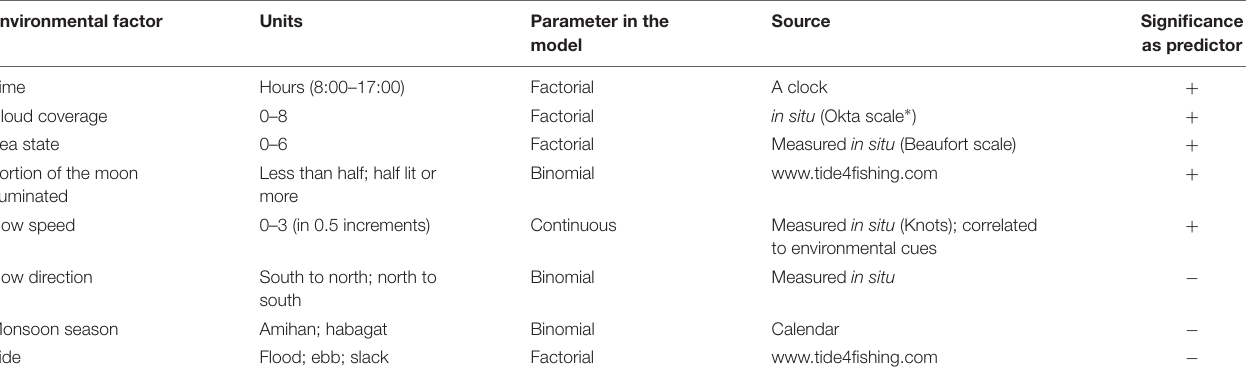
TABLE 1 | Environmental factor, parameter statistical behavior, source, and significance as predictors of manta presence. Environmental